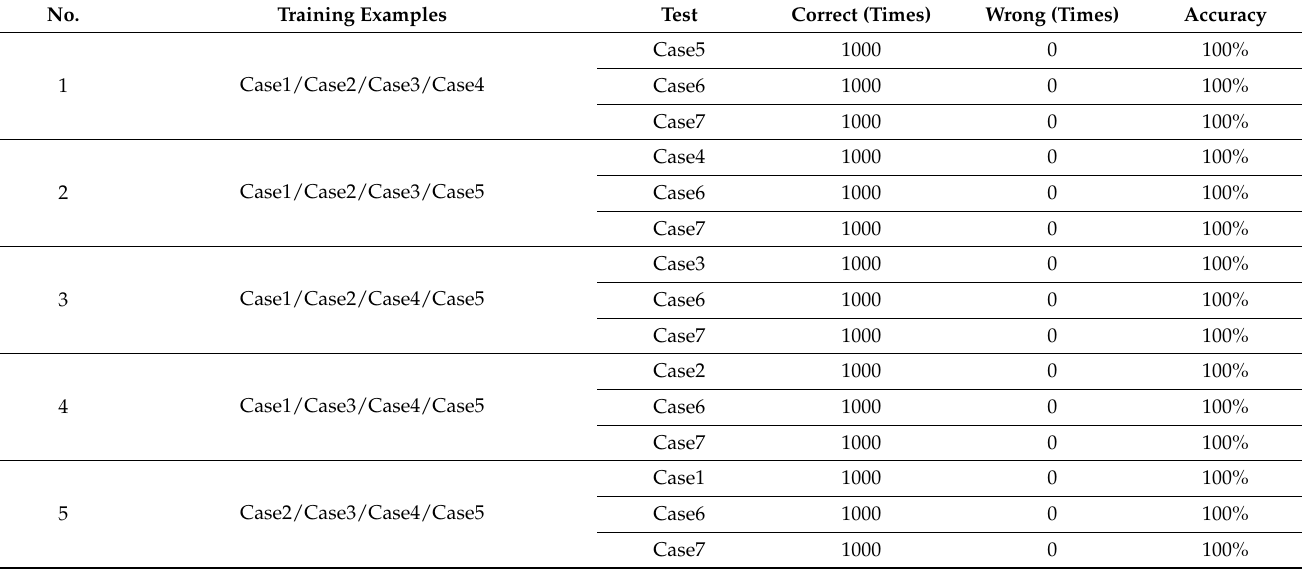
Table 3. The combination of four groups of health